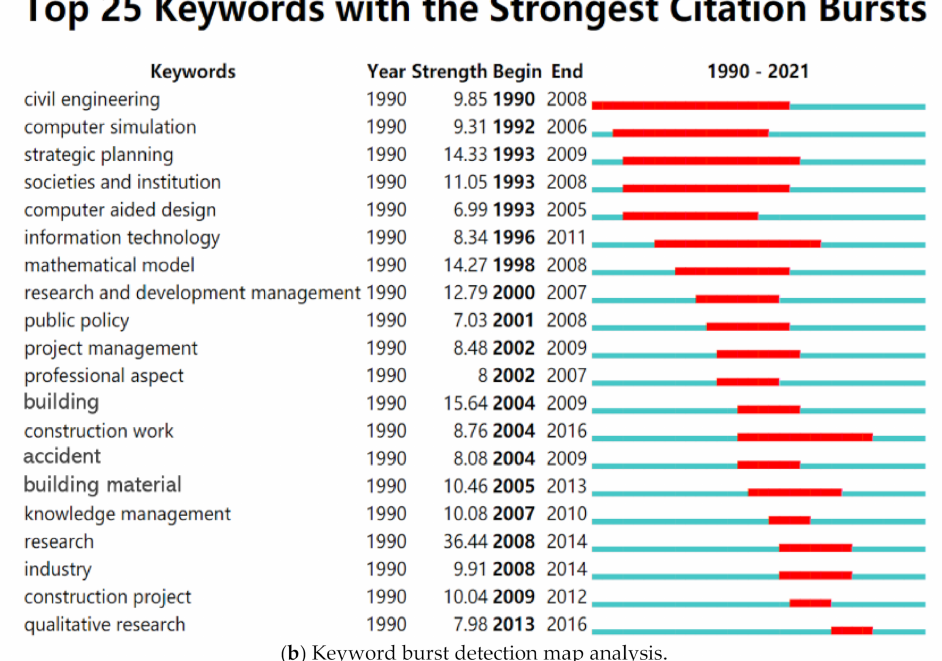
Figure 1. Cluster analysis of published